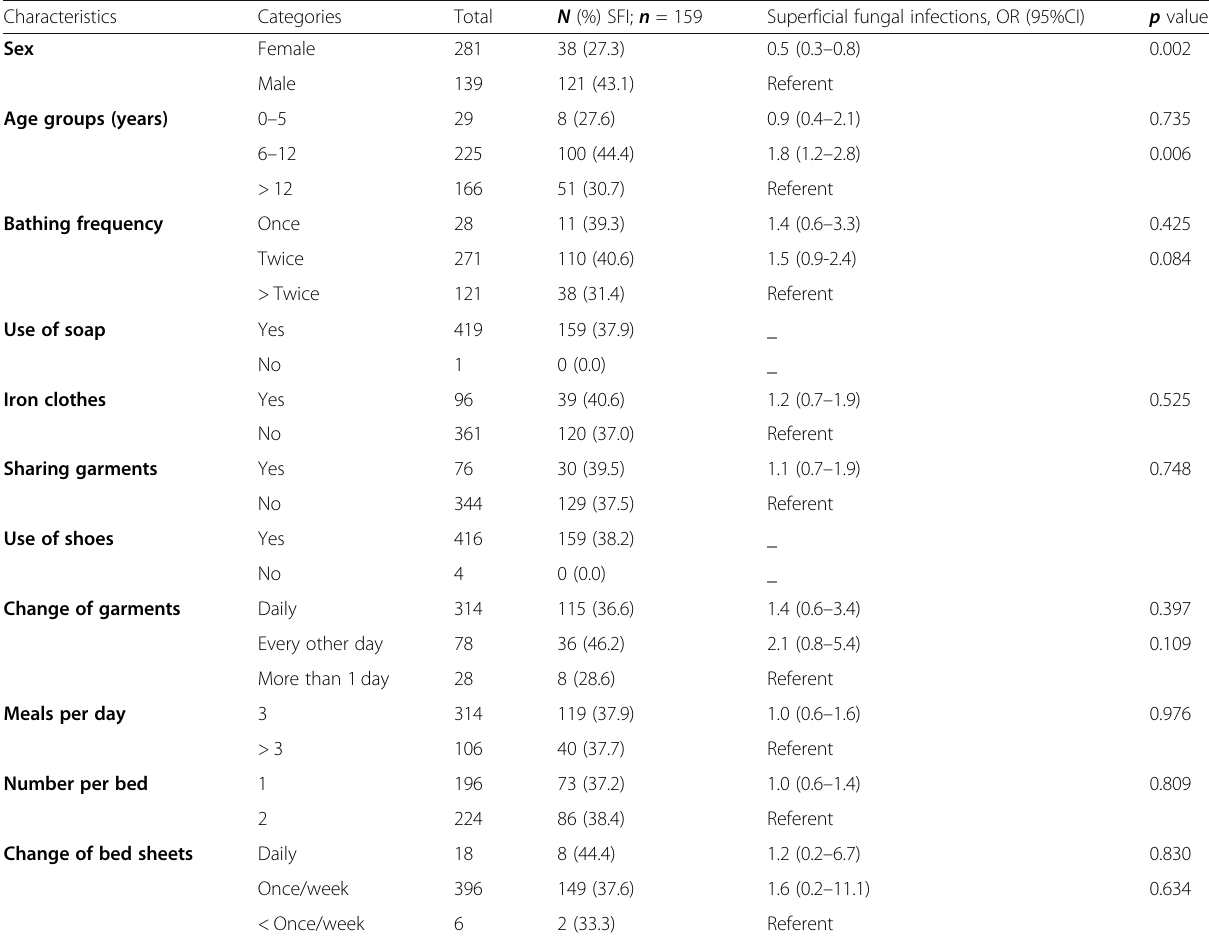
Table 5 Univariate analysis of fungal infections in relation to socio-demographic and hygienic habits of children living in orphanage centres, Dar es Salaam ( n = 420)